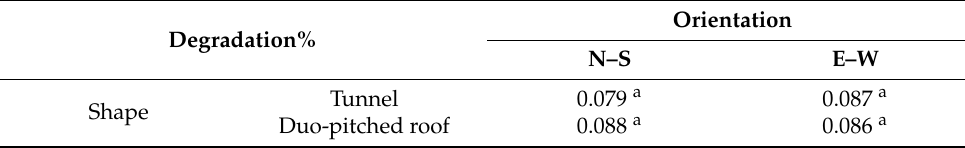
Figure 9. Time course of the degradation rate of the cover transmittance estimated for the two green- house prototypes oriented in the N–S and E–W directions and exposed to the arid climatic agents. Table 1. Average of the degradation rates (%) per day for both orientation and shape. Degradation%